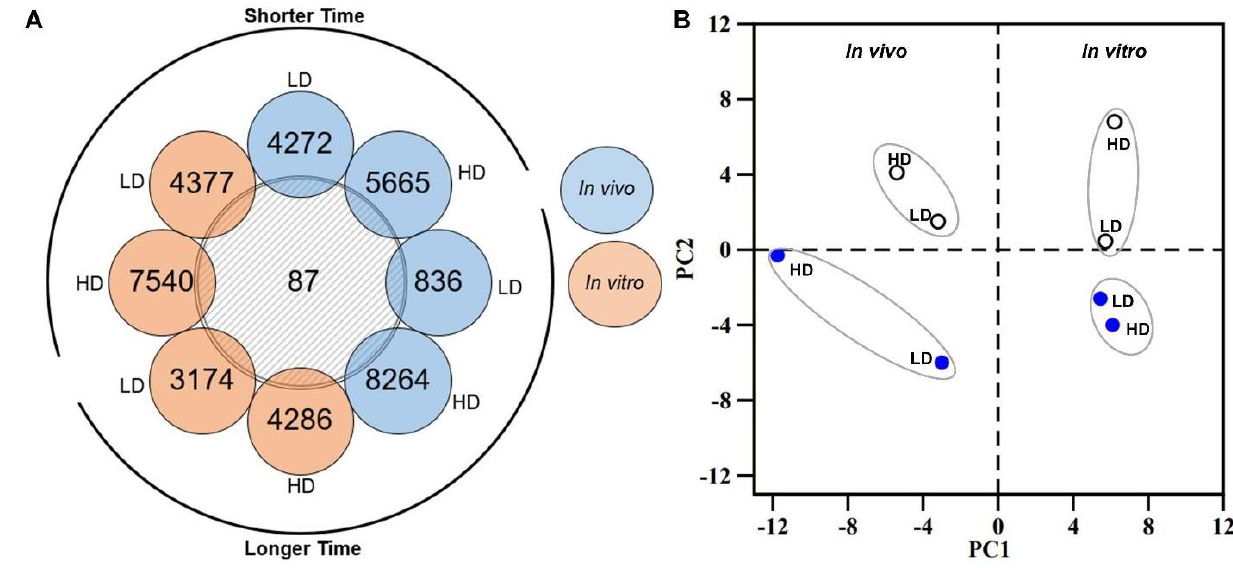
Figure 2. ( A ) Venn diagram depicting common differential expression genes (DEGs) between different times of exposure and doses of mercuric chloride for in vivo and in vitro studies. ( B ) Principal component analysis (PCA) for 87 common DEGs obtained from all conditions in the in vivo and in vitro data. The in vivo and in vitro conditions are presented on the left and right panels, respectively. The white and blue circles represent shorter and longer times of exposure, respectively. HD, high dose; LD, low dose. Table 3. The top 10 up- and downregulated differential expression genes from the 87 common genes for the different doses and exposure times in the in vivo and in vitro guinea pig data. FC, fold change. Gene (Down) log 2